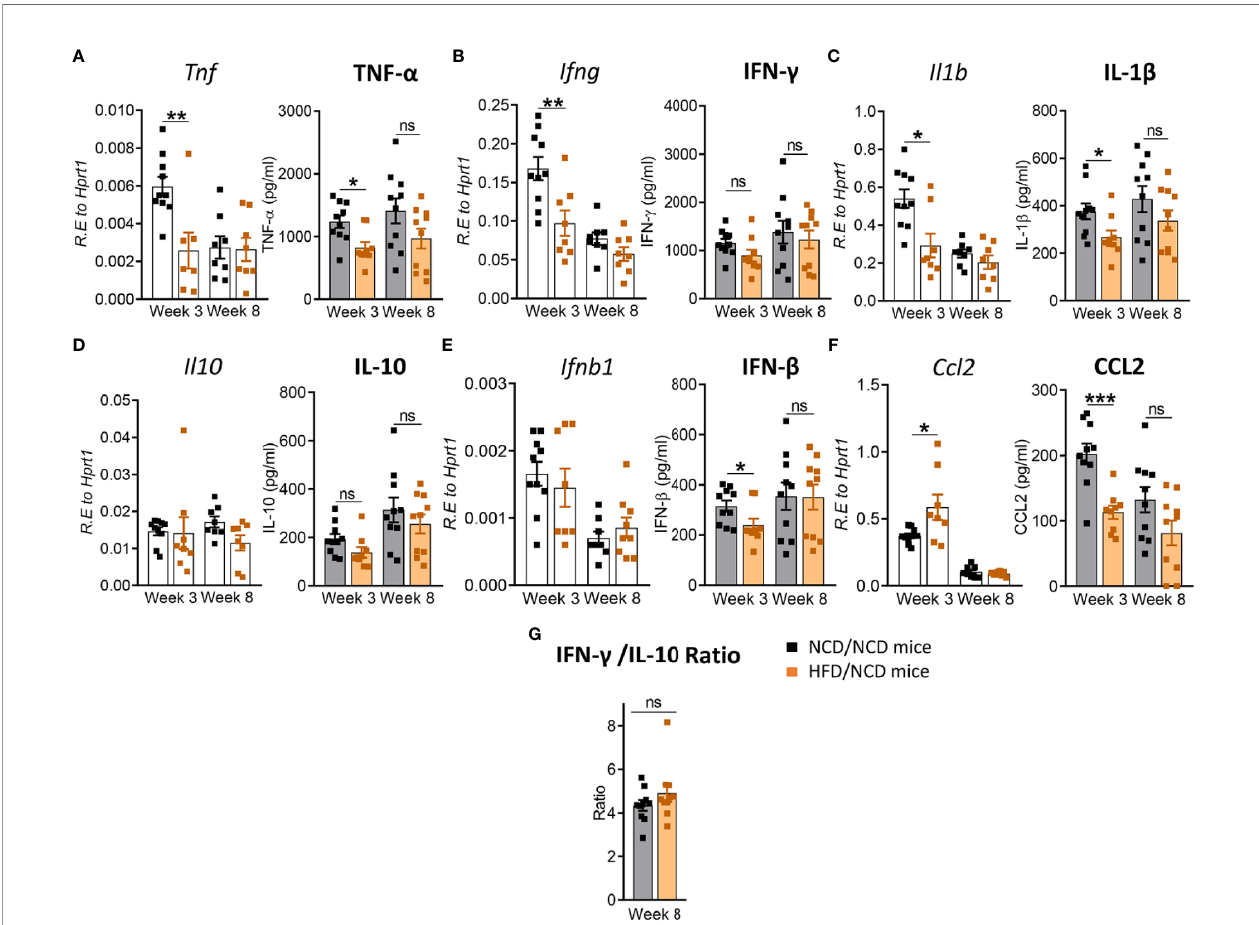
FIGURE 8 | Restoration of glucose tolerance improves lung cytokine pro fi les. Cytokine mRNA and protein levels were determined in lung homogenates by qPCR and ELISA. Lung mRNA expression and protein concentrations of (A) Tnf , TNF- a ; (B) Ifng , IFN- g ; (C) Il1b , IL-1 b ; (D) Il10 , IL-10; (E) Ifnb1 , IFN- b ; and (F) Ccl2 , CCL2 from NCD- and HFD fed-mice at 3- and 8-weeks p.i. (G) IFN- g /IL-10 ratio was determined for each mouse at week 8. Data are means ± SEM (n=8-10 mice/group analyzed in one independent experiment). Data analysis was performed by Mann-Whitney U test. ns = not signi fi cant *p < 0.05, ** p<0.01 and ***p <